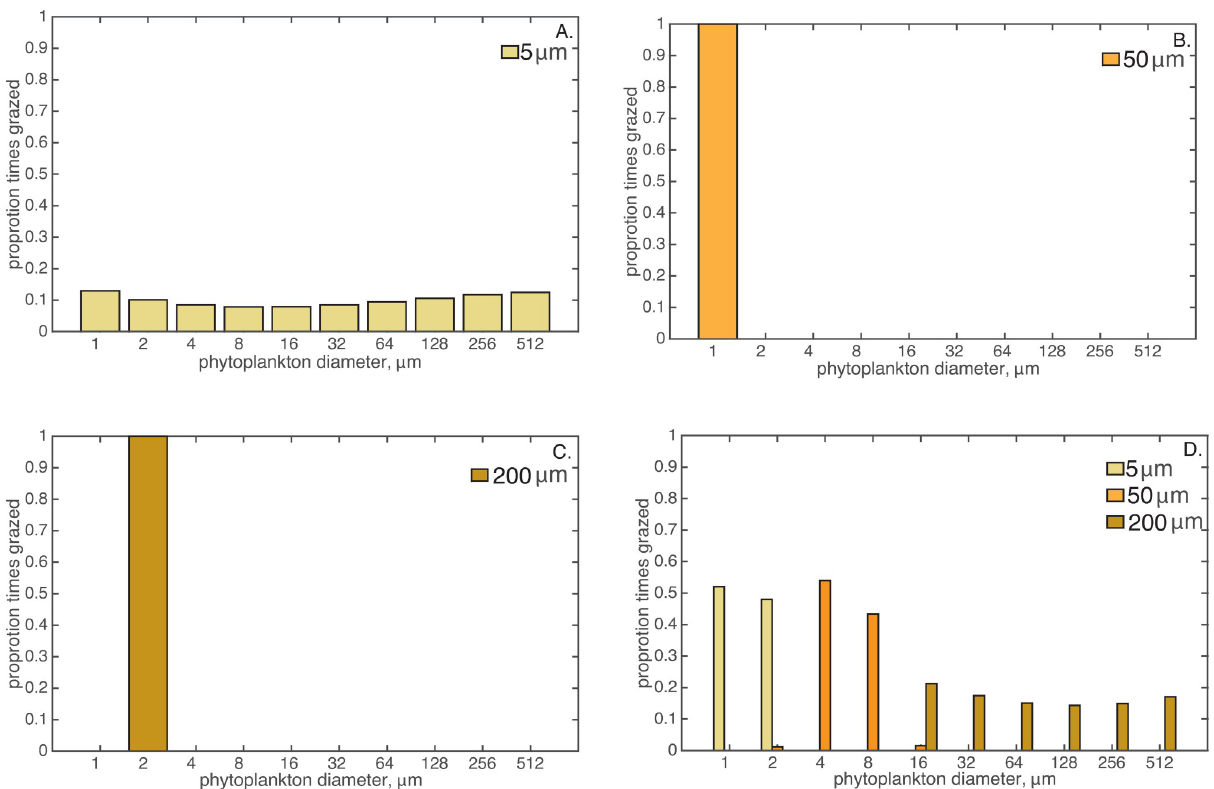
Fig 2. Proportion of times consumers grazed different sized phytoplankton during the last 3 years of a * 30 year model run time. Model run in which the grazers are all a. 5- μ m, b. 50- μ m or c. 200- μ m in diameter, and d. multi-size class grazers with 5-, 50-, and 200- μ m grazers combined.